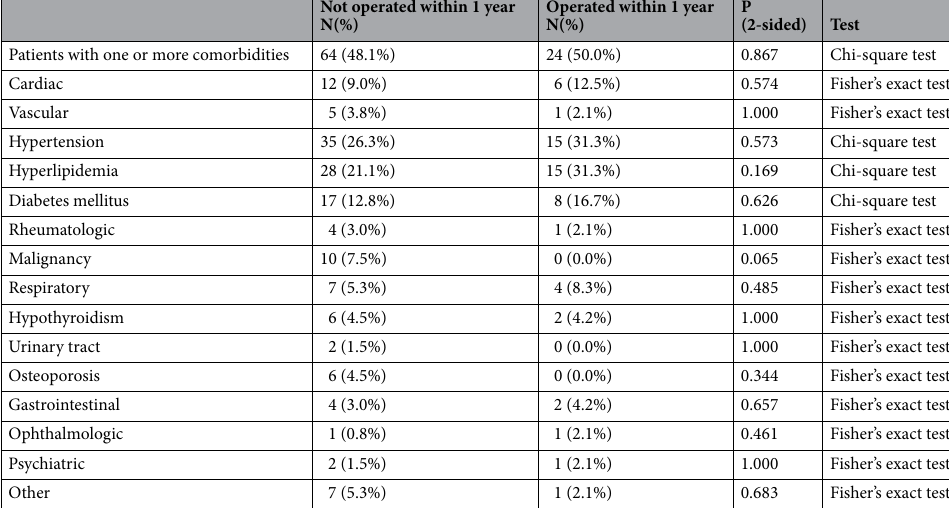
Table 3. Detailed comorbidities. No significant difference was found between the two